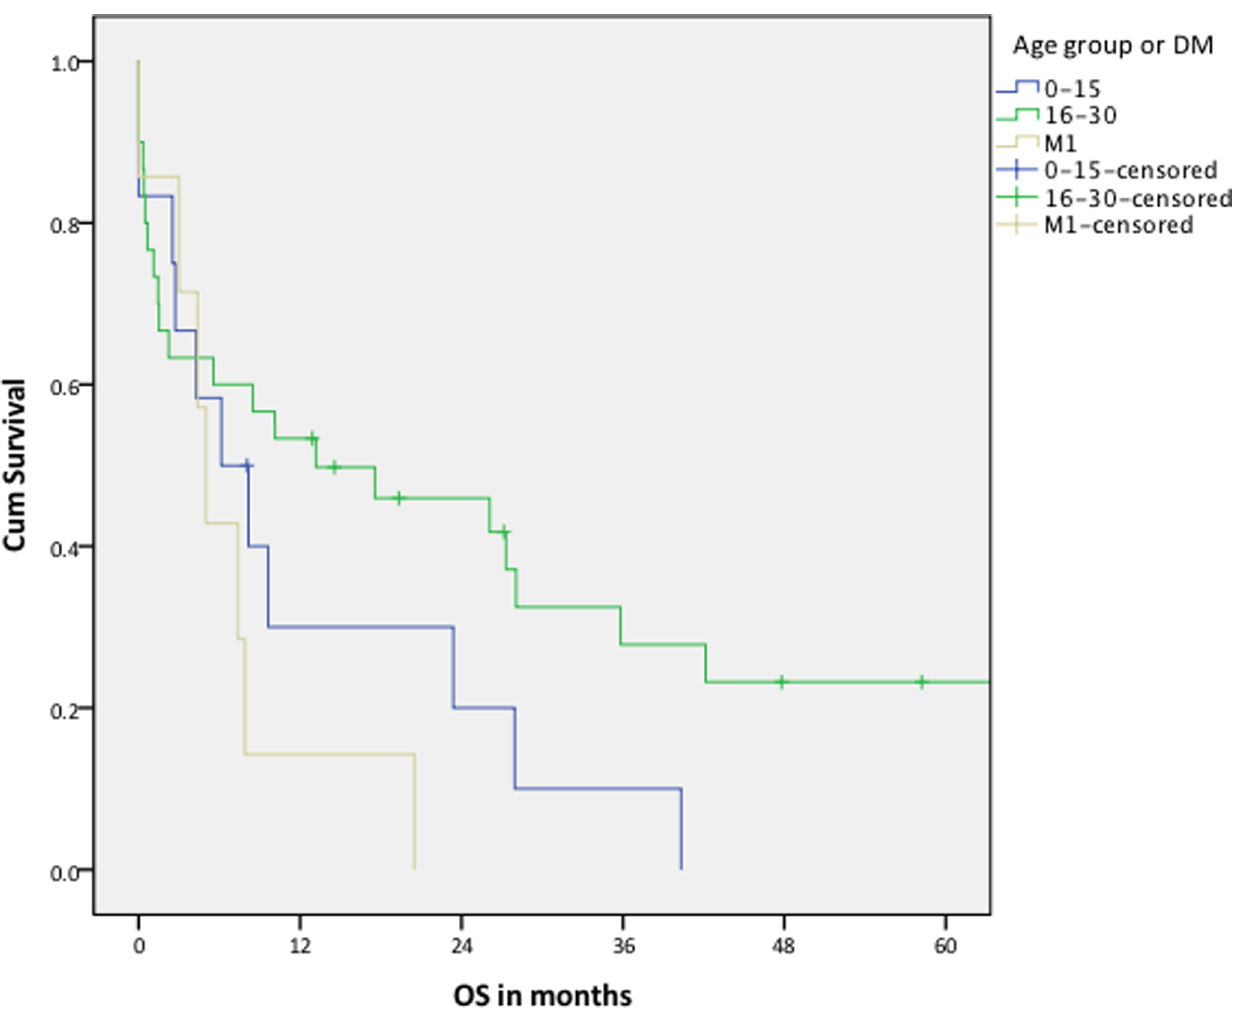
Figure 3. Overall survival: worst-case scenario. All patients who were lost to follow up before treatment (n=11) or during treatment (n=2), or who had disease at last moment of follow up (n=6) are assumed to be death (Log rank p= 0. 142, when comparing patients without distant metastasis: 0–15 vs. 16–30 year). DM = distant metastasis at diagnosis; OS = overall survival.